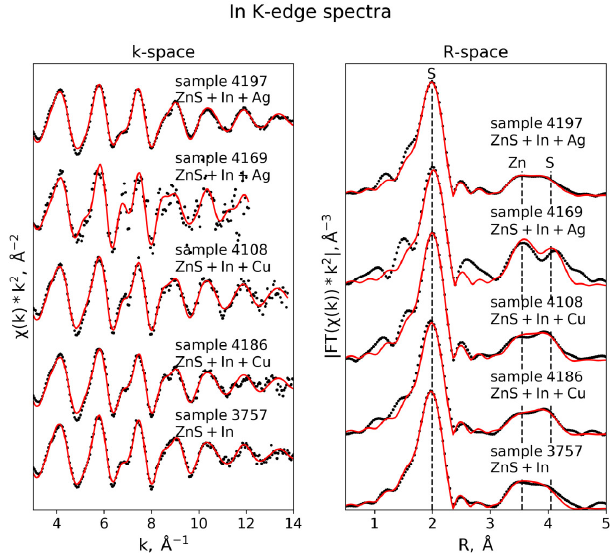
Figure 6. In K -edge EXAFS spectra of doped sphalerite samples (see caption of Figure 5 for explanation). The local atomic structure around In is not dependent on sphalerite composition and is similar to that of Zn in sphalerite. The first peak shows the presence of four S at 2.45–2.49 Å, and the peaks at 3–4.5 Å (not corrected for phase shift) correspond to 12 Zn at 3.90–3.93 Å and 12 S at 4.47–4.54 Å in the second and third coordination shells,